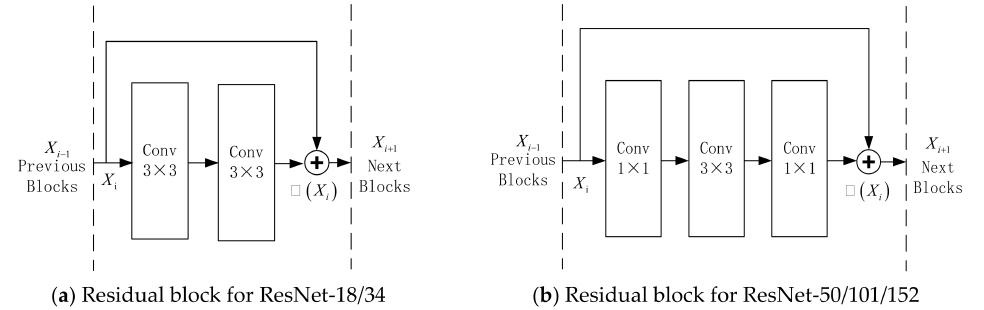
Figure 1. Residual blocks.